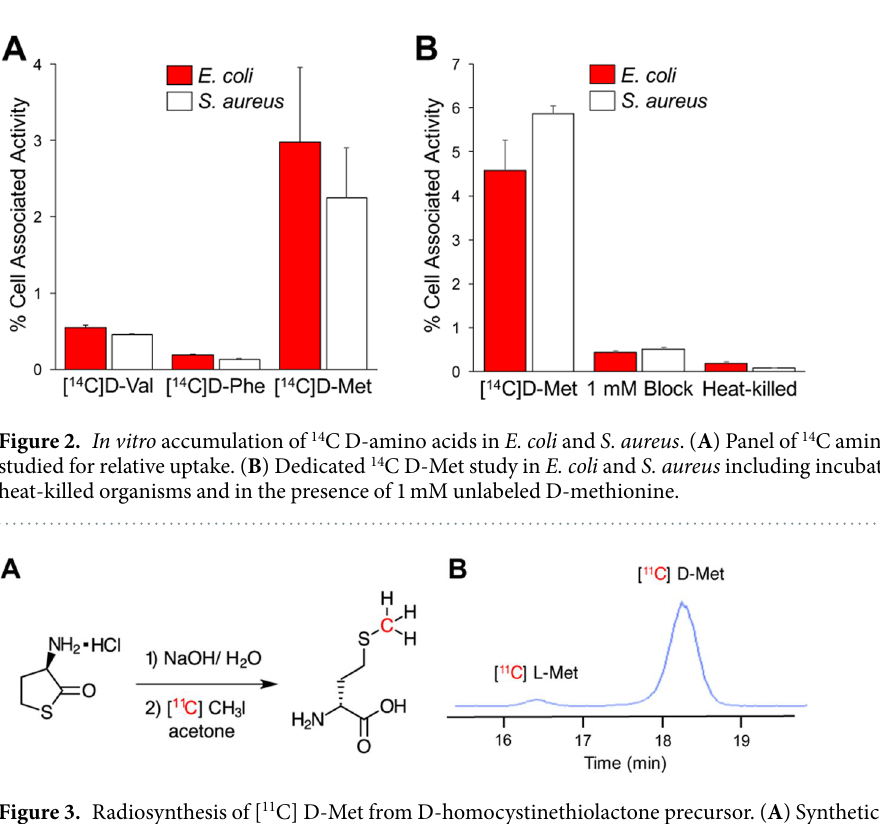
Figure 3. Radiosynthesis of [ 11 C] D-Met from D-homocystinethiolactone precursor. ( A ) Synthetic scheme. ( B ) Chiral stationary-phase HPLC showing enhanced enantiomeric excess synthesis of [ 11 C]